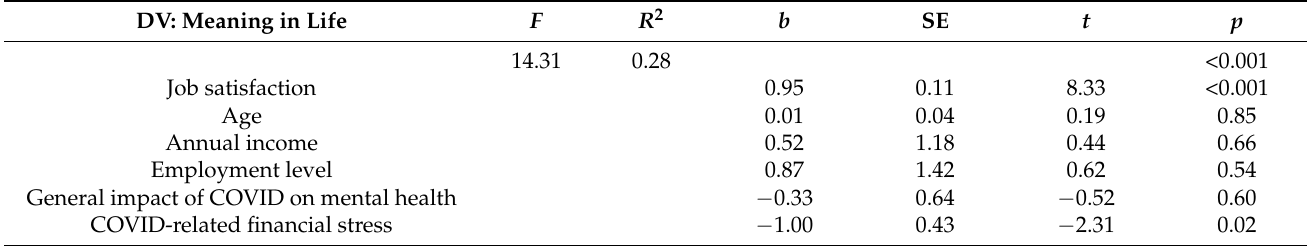
Table 2. Results of regression analyses examining the indirect effect of job satisfaction on psychologi- cal distress, through meaning in life as a